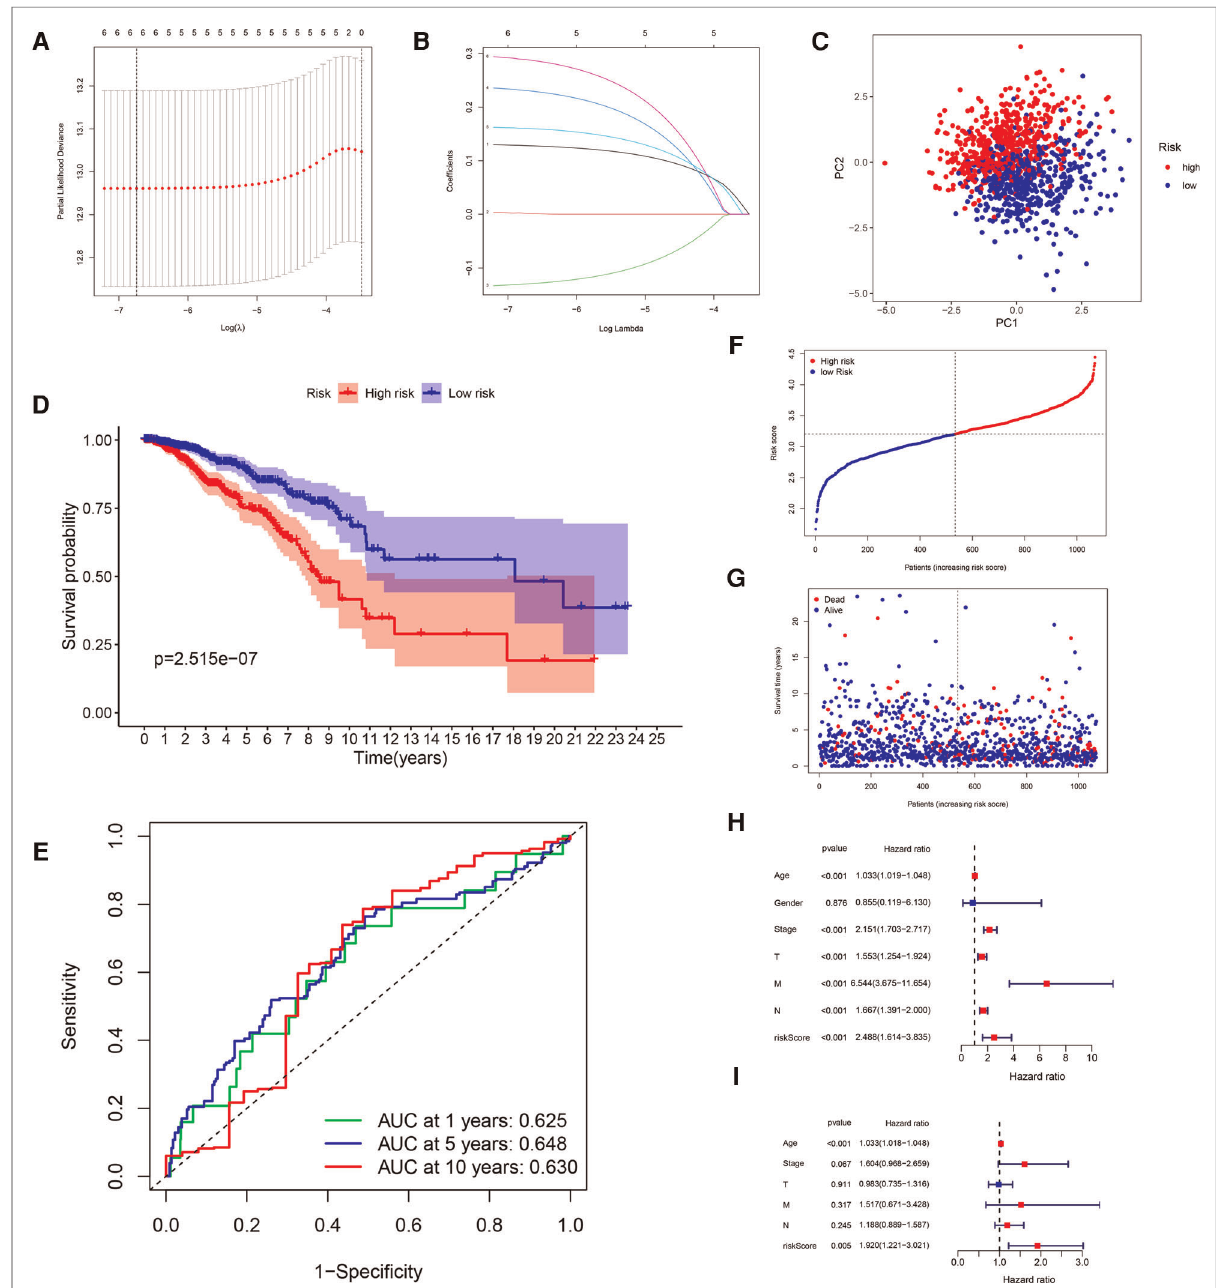
FIGURE 3 Construction of a GRG signature in TCGA cohort. ( A ) Selection of the optimal GRG candidates in the LASSO analysis. ( B ) LASSO coef fi cients of the optimal GRG candidates. ( C ) PCA based on risk score of GRGs. ( D ) Kaplan – Meier survival curves between high-risk and low-risk groups. ( E ) The ROC curves of 1-, 5- and 10-years OS. ( F,G ) Survival status of each patient. ( H,I ) Univariate and multivariate Cox regression